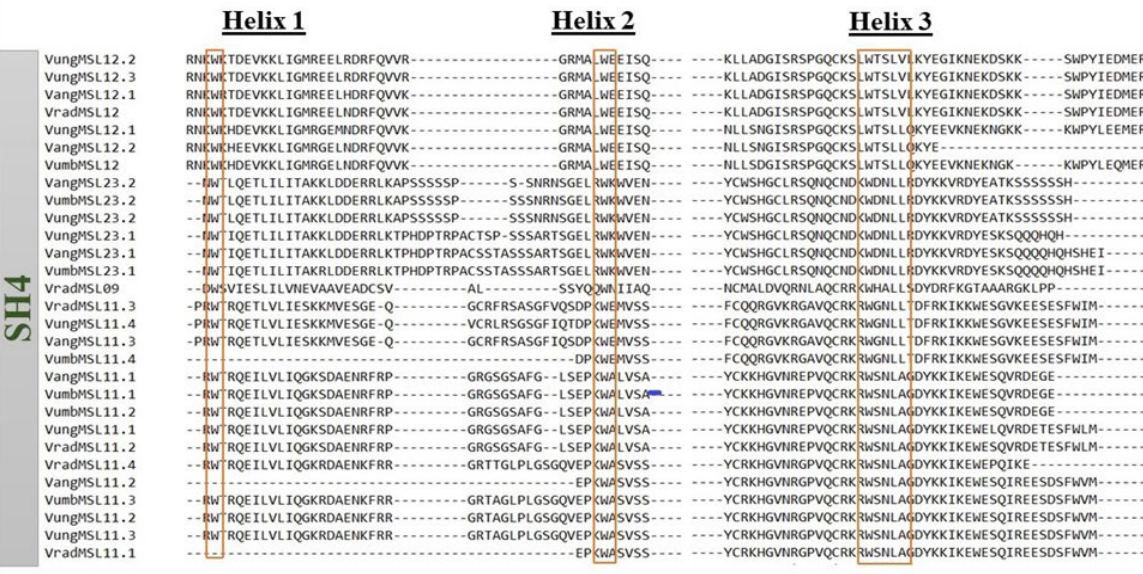
Figure 4. Sequence alignment of trihelix domain of SH4 group present in Vigna species. The three boxes represent the three helices of trihelix domain and sequence included in orange box represents conservation of tryptophan (W) present in the domain.